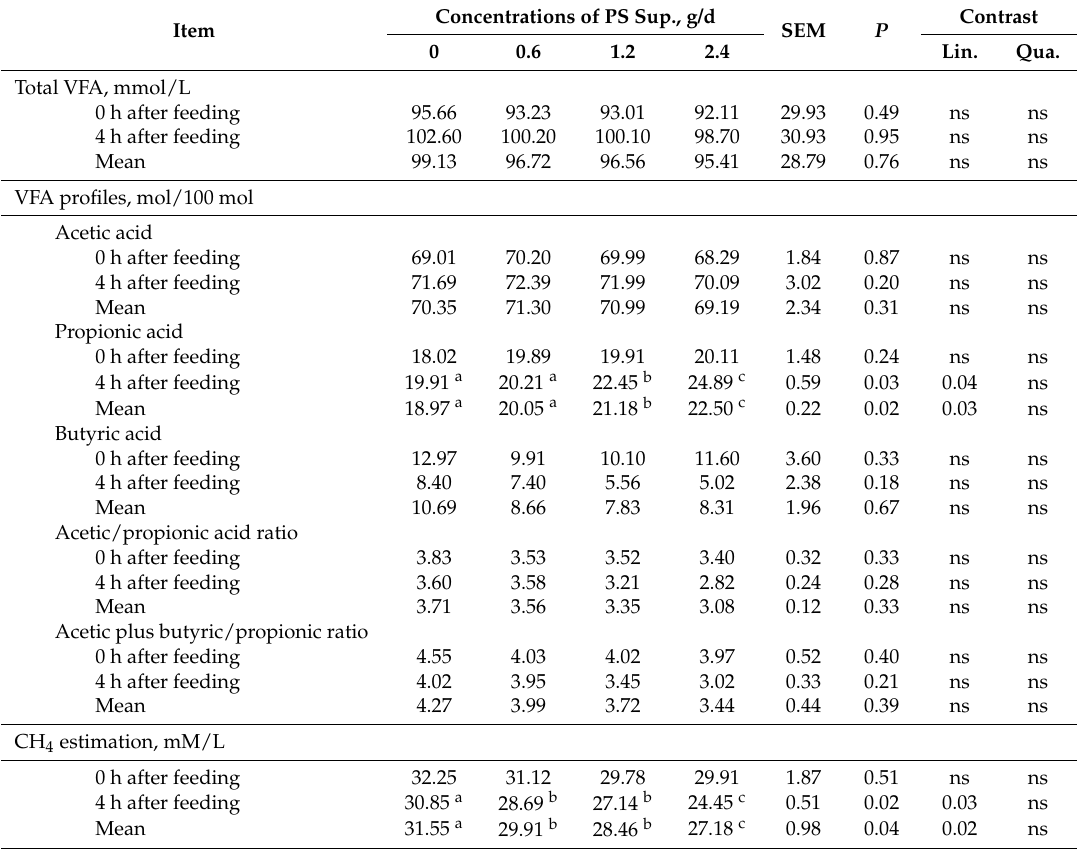
Table 4. Effect of supplementation of Piper sarmentosum (PS) leaf meal on ruminal volatile fatty acid (VFA) profile and methane (CH 4 )